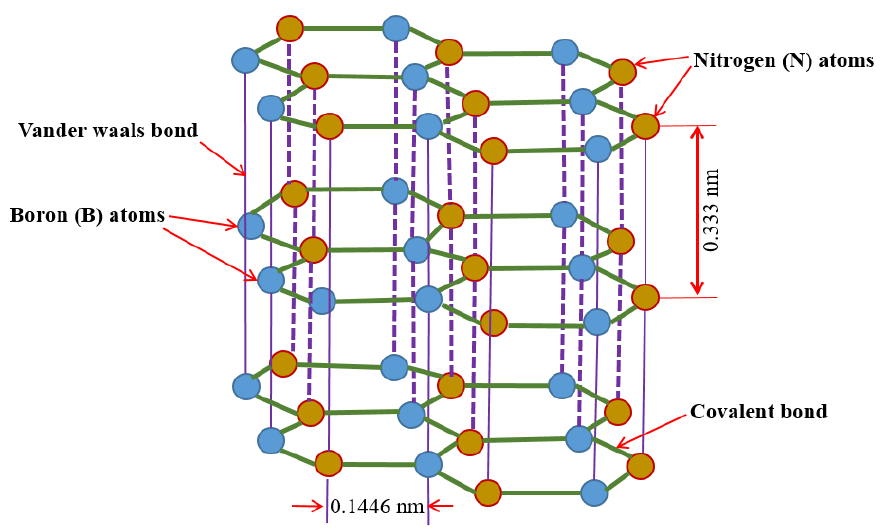
Figure 1. Crystal structure representation of the hexagonal boron nitride (h–BN).